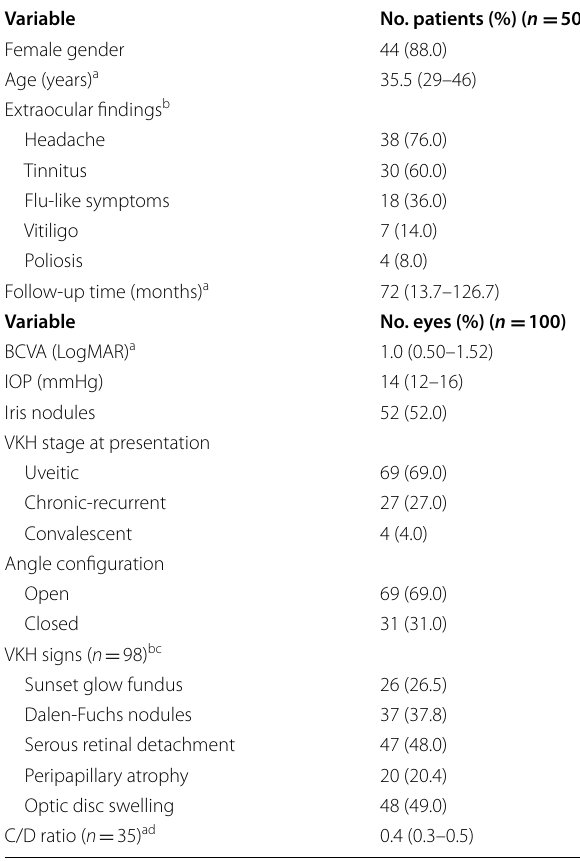
Table 1 Baseline characteristics of patients presenting with